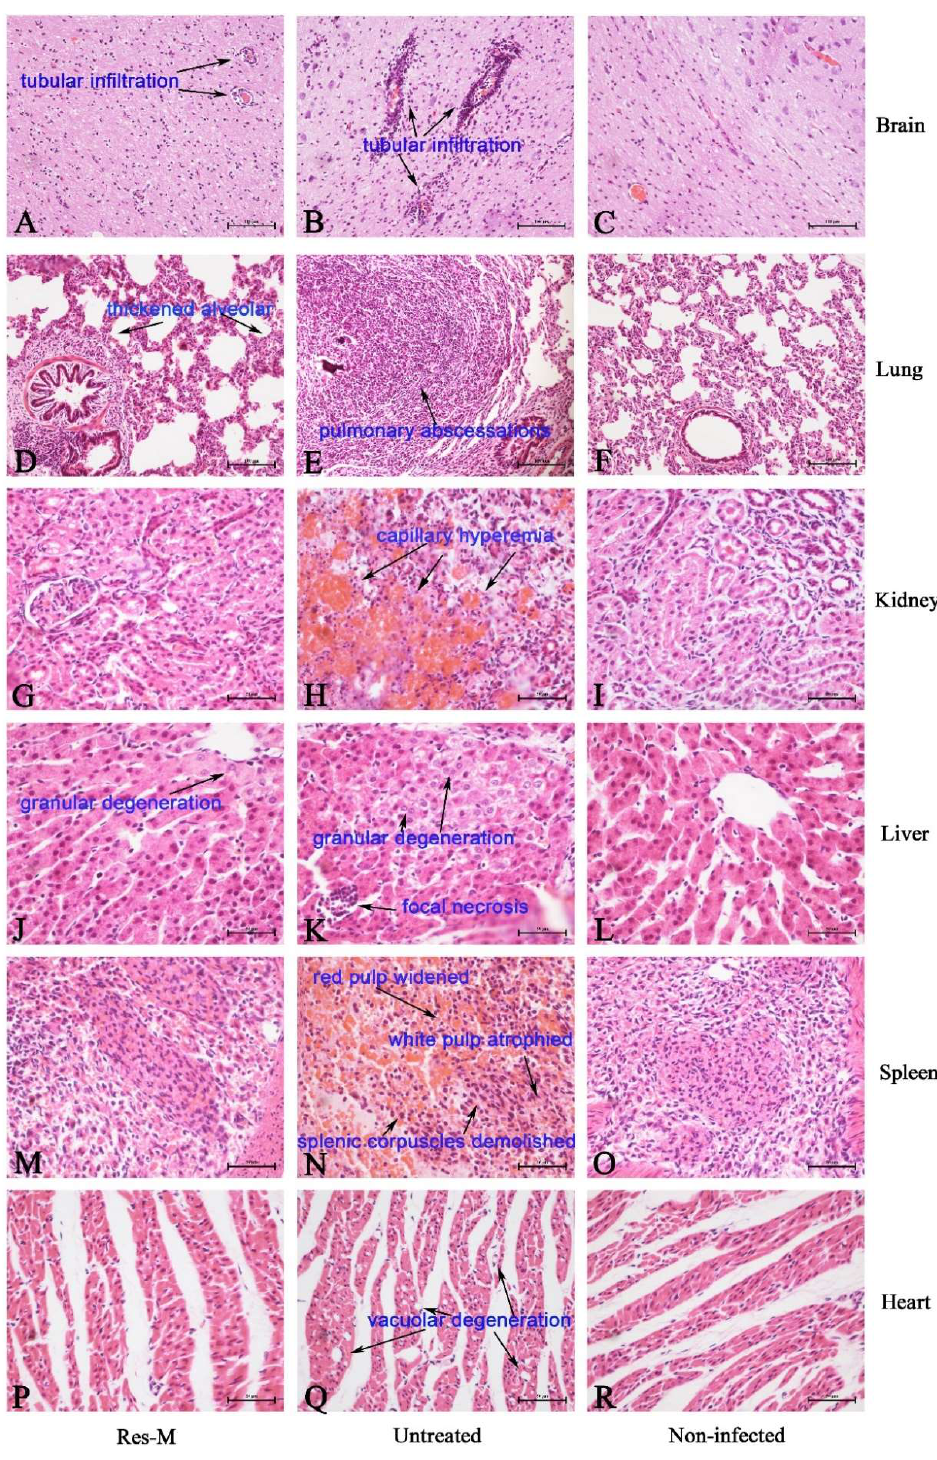
Figure 4. Effect of Res on the microstructures of tissues of piglets at 7 dpi. Panels ( A – C ): brain of Res-M, Untreated and Non-infected groups, respectively. Panels ( D – F ): lung of Res-M, Untreated and Non-infected groups, respectively. Panels ( G – I ): kidney of Res-M, Untreated and Non-infected groups, respectively. Panels ( J – L ): liver of Res-M, Untreated and Non-infected groups, respectively. Panels ( M – O ): spleen of Res-M, Untreated and Non-infected groups, respectively. Panels ( P – R ): heart of Res-M, Untreated and Non-infected groups, respectively. Final magnification ×400, bars = 100 μm.